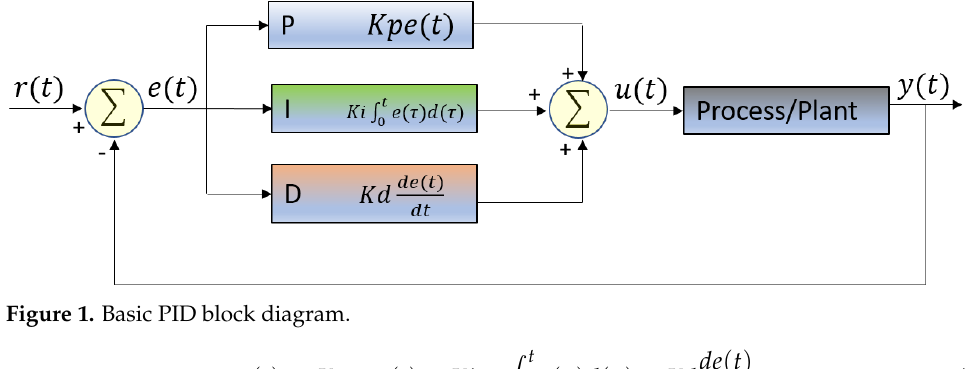
Figure 1. Basic PID block